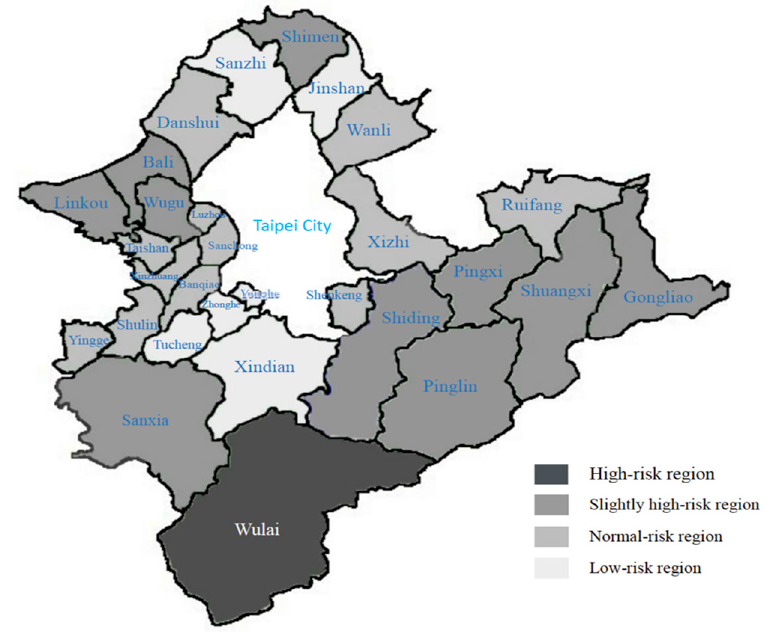
Figure 2. Distribution of severity of metabolic syndrome in New Taipei City.